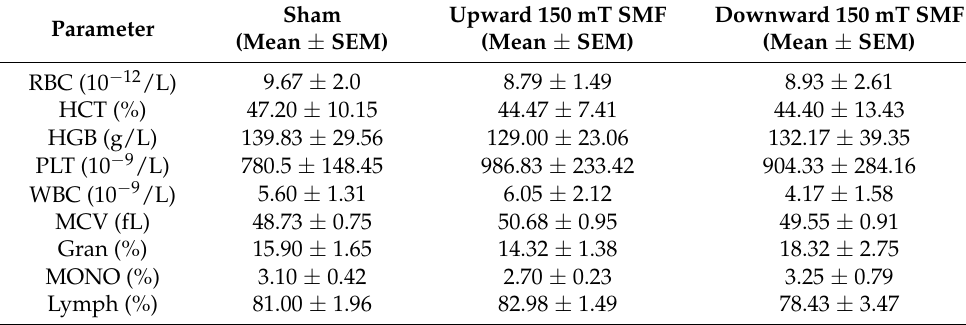
Figure 2. Effect of long-term 150 mT SMFs exposure on food and water intake, body weight and blood glucose in the female mice. Food ( A ) and water ( B ) consumed weekly by every mouse. ( C ) Relative body weight increased weekly. ( D ) Blood glucose of mice exposed to sham and 150 mT SMFs. At week 4, the bedding contained food residues, and fasting led to high blood glucose. We did statistical analysis for all data, and values show mean ± SEM, and “*” means p < 0.05, “****” means p < 0.0001. In consideration of the readability of the paper, no statistical significance ( p > 0.05) was not labeled uniformly. Table 1. Complete blood count examination of long-term 150 mT SMFs and sham exposure. Com- parisons were made between the sham and upward or downward 150 mT SMF groups Values show mean ± SEM, and statistical analysis was conducted for all data. In consideration of the readability of the paper, we did not label the data which had no statistical significance ( p >